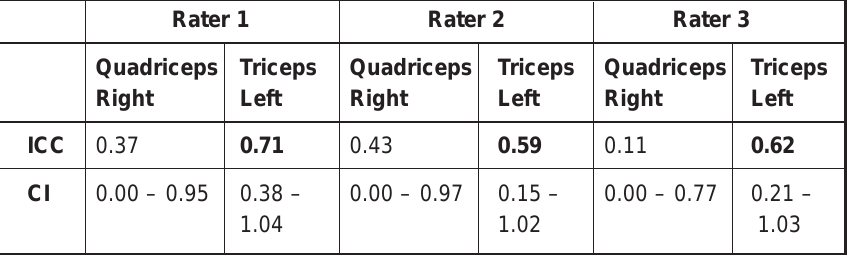
Table 6: ANOVA results for intra-observer correlation for dynamometry (n =